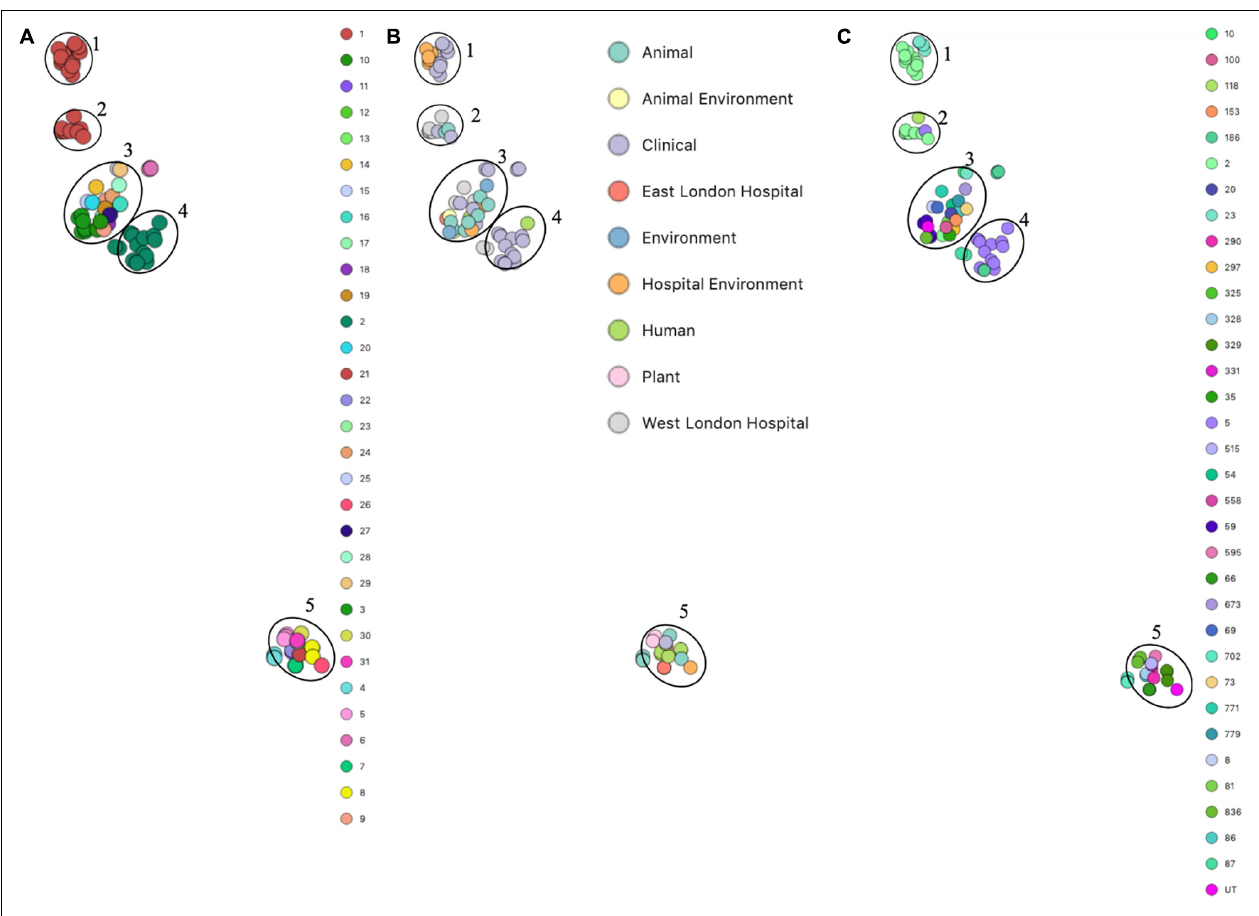
FIGURE 2 | PopPUNK t-SNE analyses of accessory genomes of 90 S. epidermidis isolates.Analyses were performed using PopPUNK pipeline. A maximum number of mixture components were set at 5 and for the perplexity of t-SNE set at 20. (A) Combined core and accessory genome cluster from PopPUNK analysis; (B) Isolation source and (C)